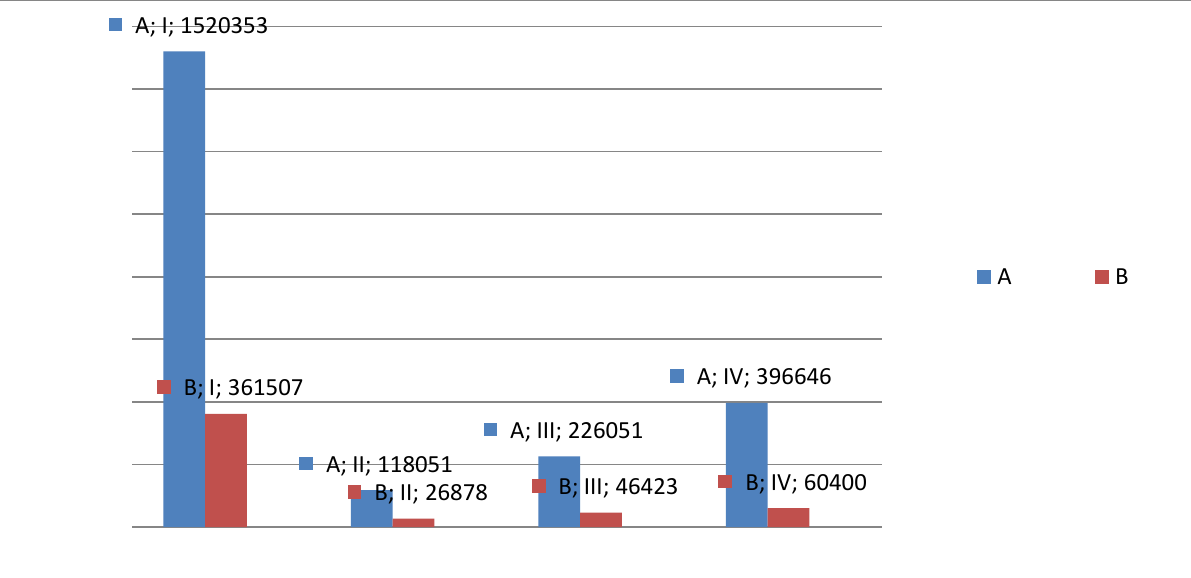
Fig.1. Correlation of quantity of persons, practicing all kinds of health related physical culture and quantity of special health groups’